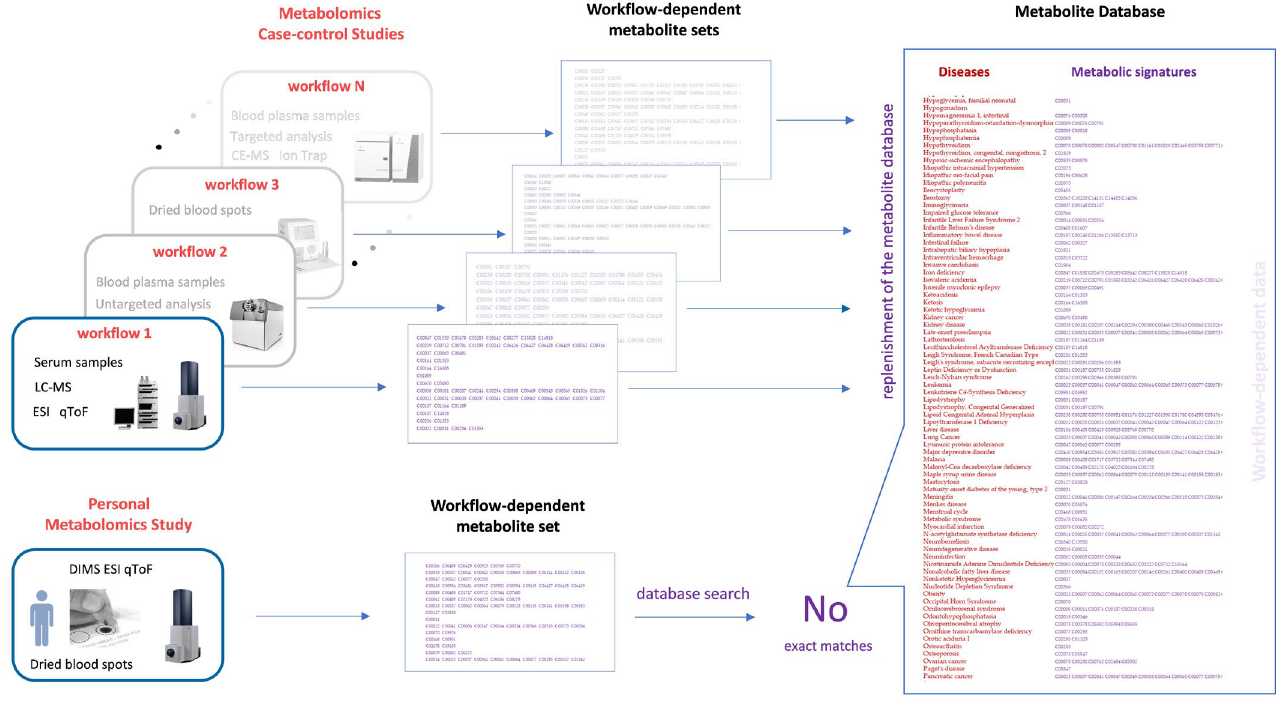
Figure 3. The workflow-dependent challenge of personal metabolomics. The sets of metabolites (including metabolic signatures of diseases) presented in the databases correspond to the protocols used for the metabolomic studies, which are diverse. Personal metabolic analysis is done according to its own protocol and cannot match all of the signatures obtained in various metabolomic studies and presented in the metabolite databases. Kyoto Encyclopedia of Genes and Genomes identifiers are shown for the metabolites. LC-MS, liquid chromatography-mass spectrometry; DIMS, direct-injection mass spectrometry; ESI, electrospray ionization; qToF, quadrupole time of flight; CE-MS, capillary electrophoresis-mass spectrometry.